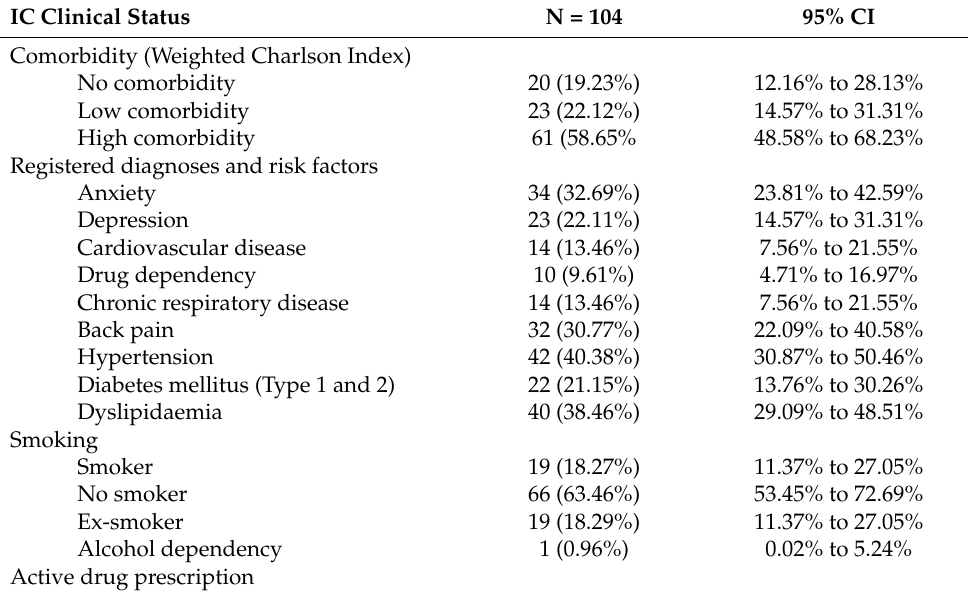
Table 2. Caregiver health status, risk factors, PHC services use, and health-related quality of